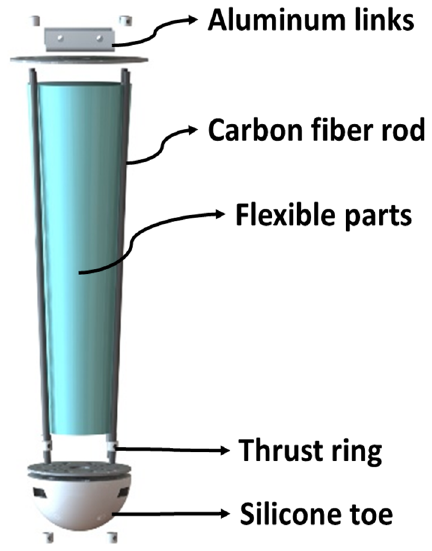
Figure 1. Explosion view of rigid and flexible coupling legs.